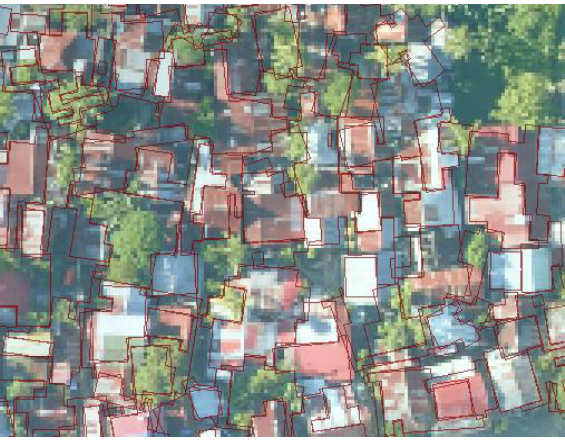
Figure 4. Regularized outline form of adjacent buildings-merged and overlapped.